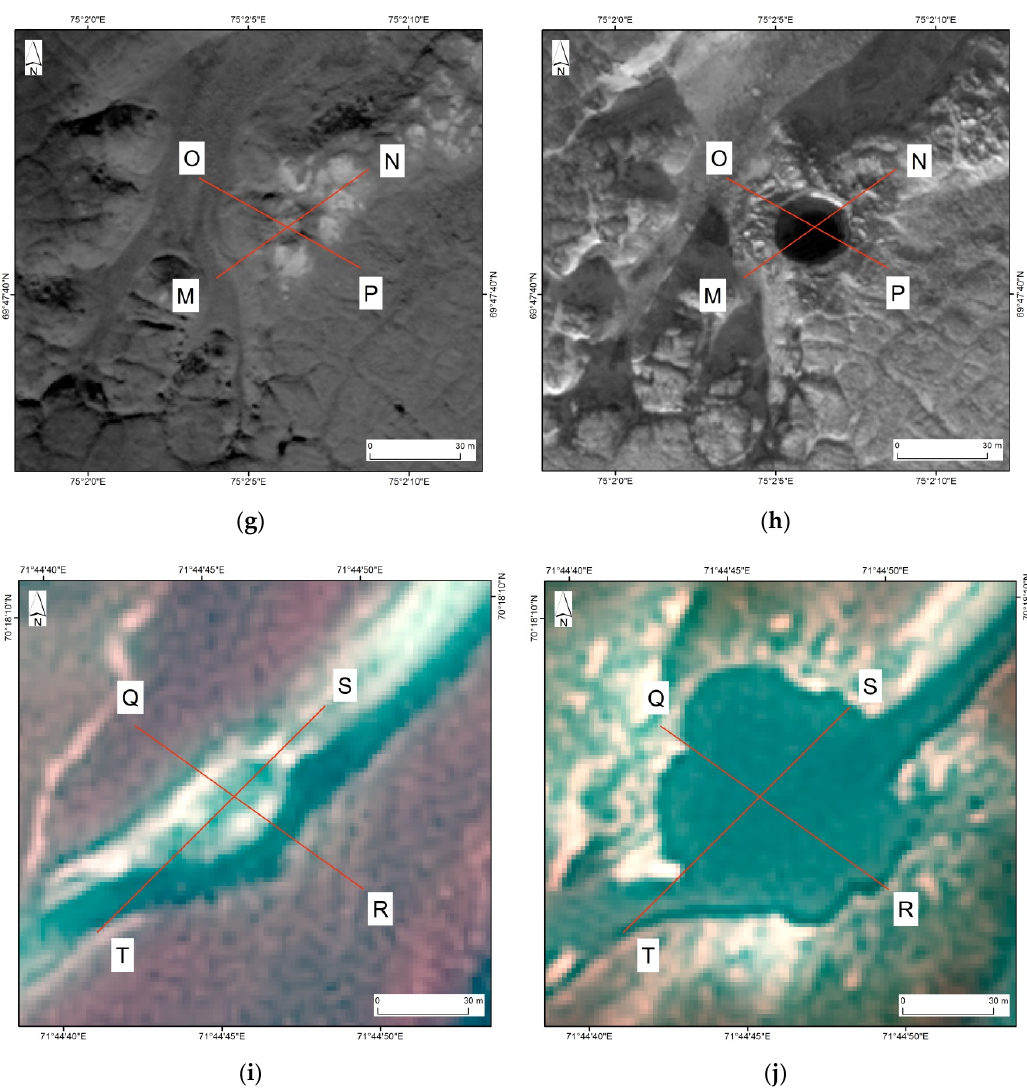
Figure 4. Satellite images before (left frame) and after (right frame) gas emission craters formation. GEC-1: ( a ) WorldView-1 image dated 09 June 2013 (pan) (mound in the center); ( b ) WorldView-1 image dated 15 June 2014 (pan) (crater with parapet in the center). GEC-2: ( c ) WorldView-2 image dated 11 September 2011 (synthesis of Red+Green+Blue) (mound in the center); ( d ) WorldView-2 image dated 21 July 2013 (synthesis of Red+Green+Blue) (inner lake in the center). GEC-3: ( e ) WorldView-1 image dated 09 June 2011 (pan) (mound in the center); ( f ) WorldView-2 image dated 10 June 2013 (synthesis of Red+Green+Blue) (inner lake in the center). AntGEC: ( g ) WorldView-2 image dated 21 August 2013 (pan) (mound in the center); ( h ) WorldView-1 image dated 11 October 2014 (pan) (crater in the center). SeYkhGEC: ( i ) SPOT7 image dated 19 July 2016 (synthesis of NIR+Red+Green) (mound in the center); ( j ) SPOT7 image dated 27 July 2017 (synthesis of NIR+Red+Green) (riverbed expansion in the center). Red lines indicate a position and letter designation of elevation profiles shown in Figure 5.